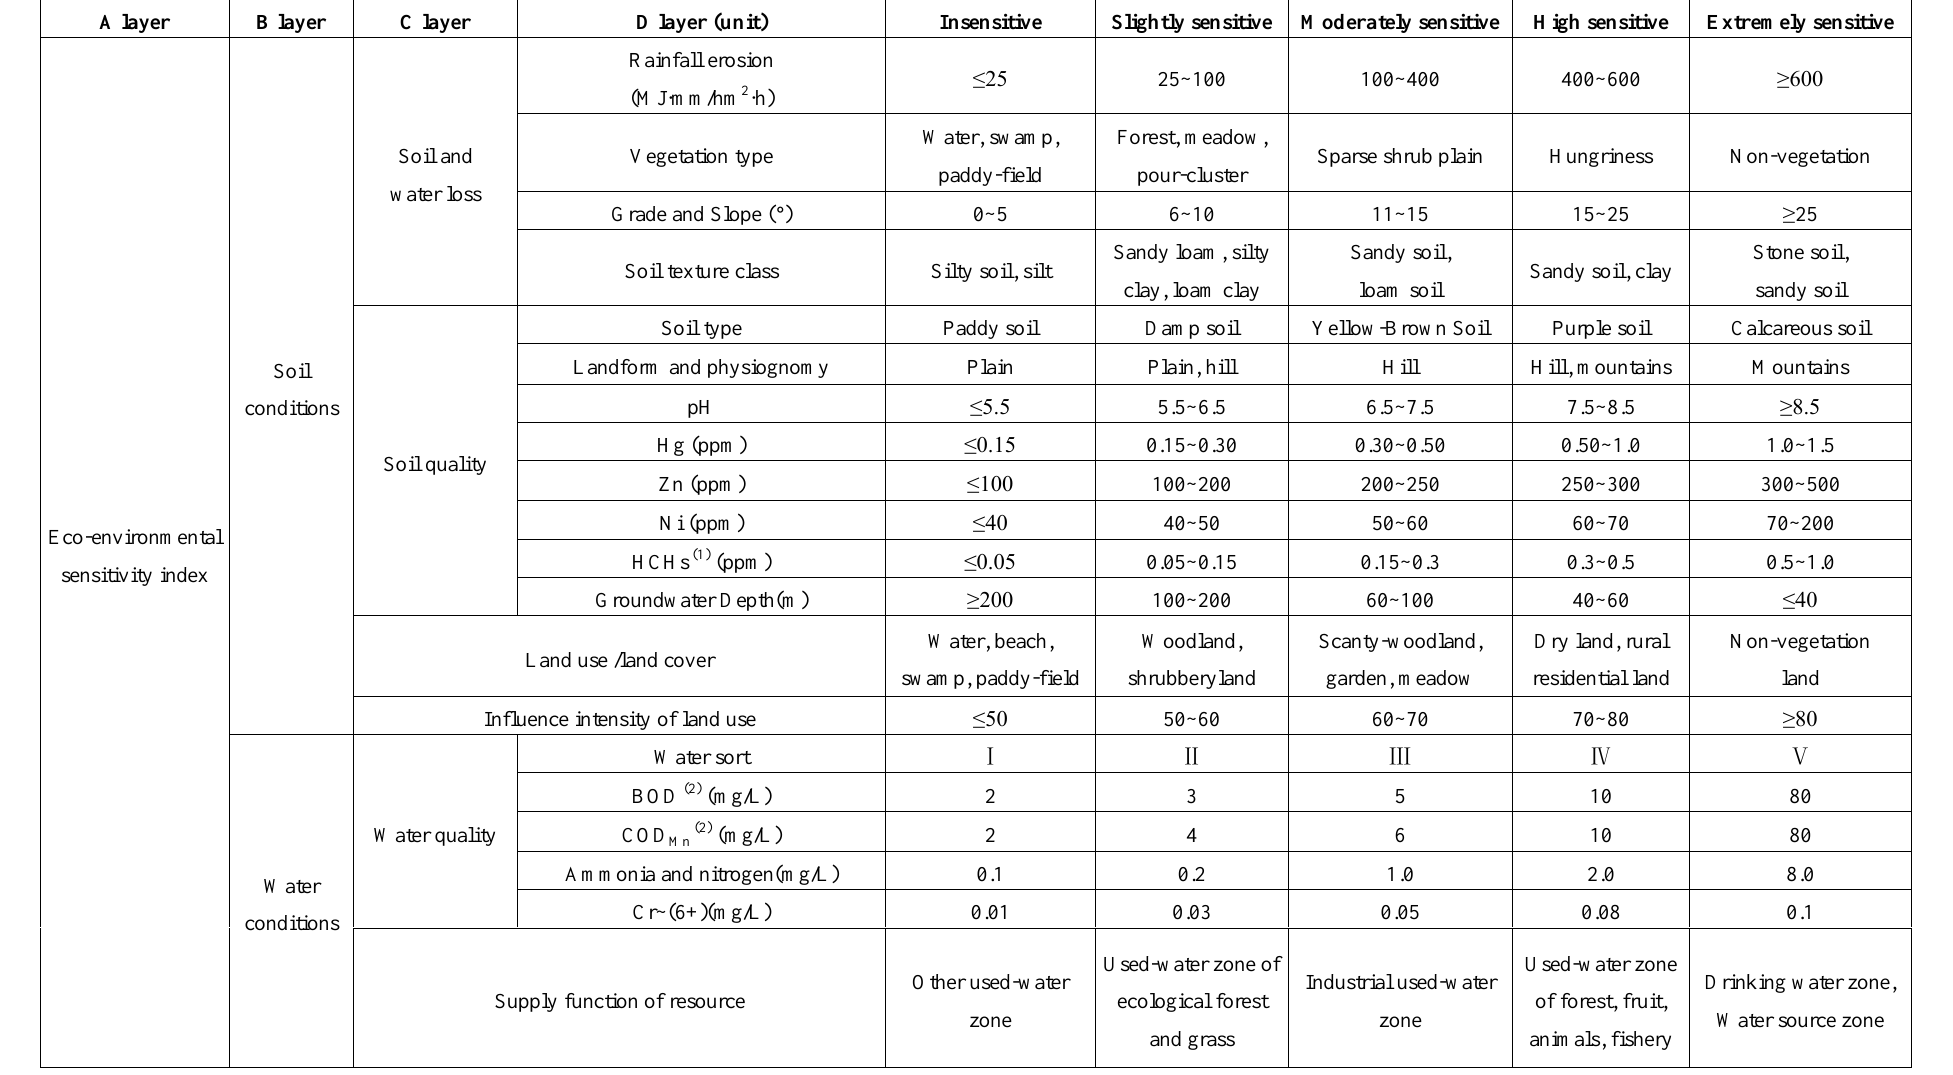
Table 1. The evaluation index and grade system of eco-environmental sensitivity on land use